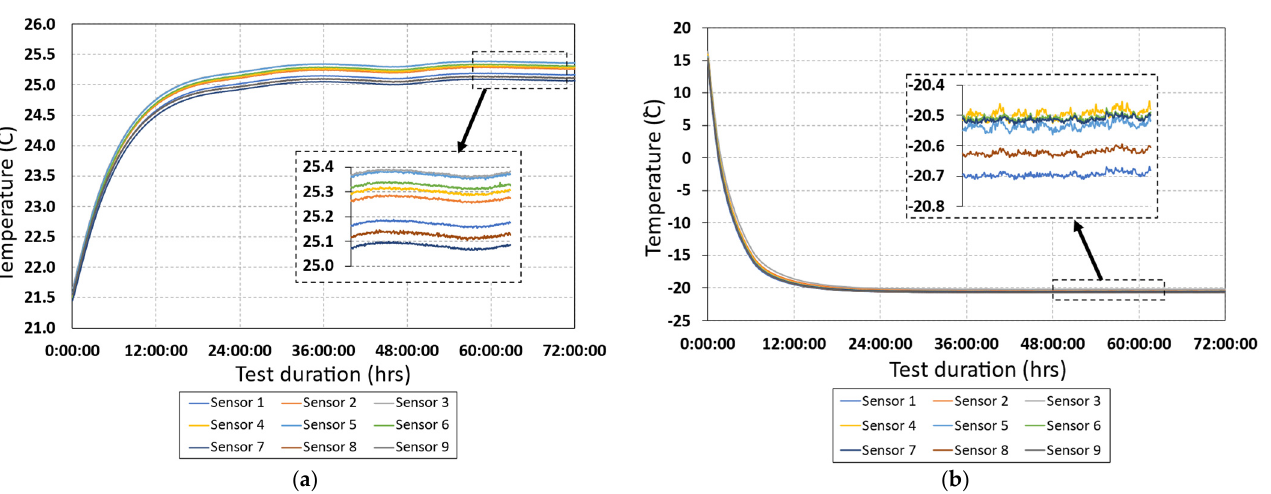
Figure 6. Air curtain temperature profile of: ( a ) metering chamber; ( b ) climate chamber.